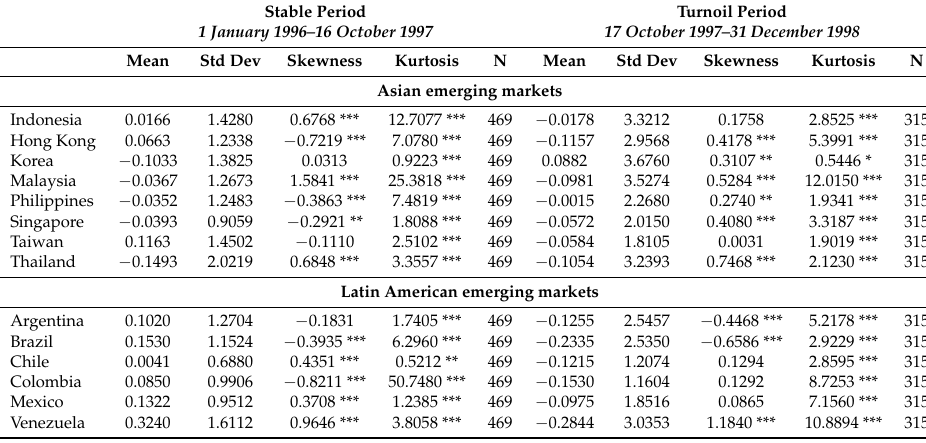
Table 3. Descriptive statistics on stock returns: The Asian Crisis (Source of contagion: Hong Kong).